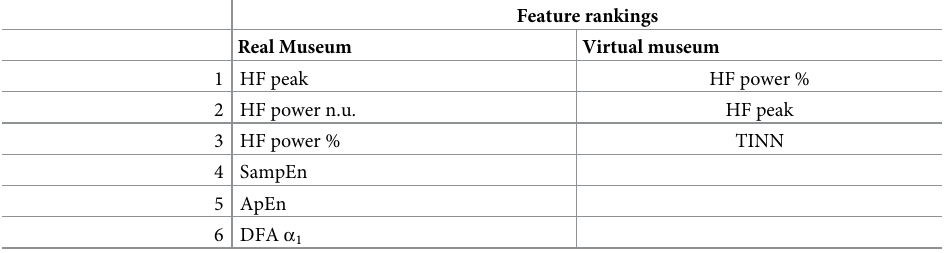
Table 5. Feature ranking of the arousal recognition model in both the real and the virtual museum